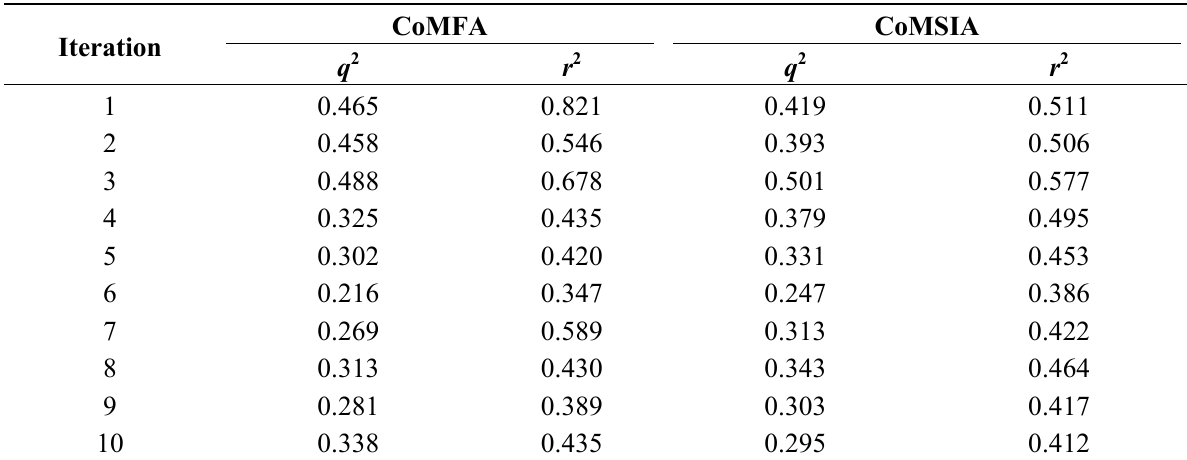
Table 3. q 2 and r 2 values after several Y-randomization